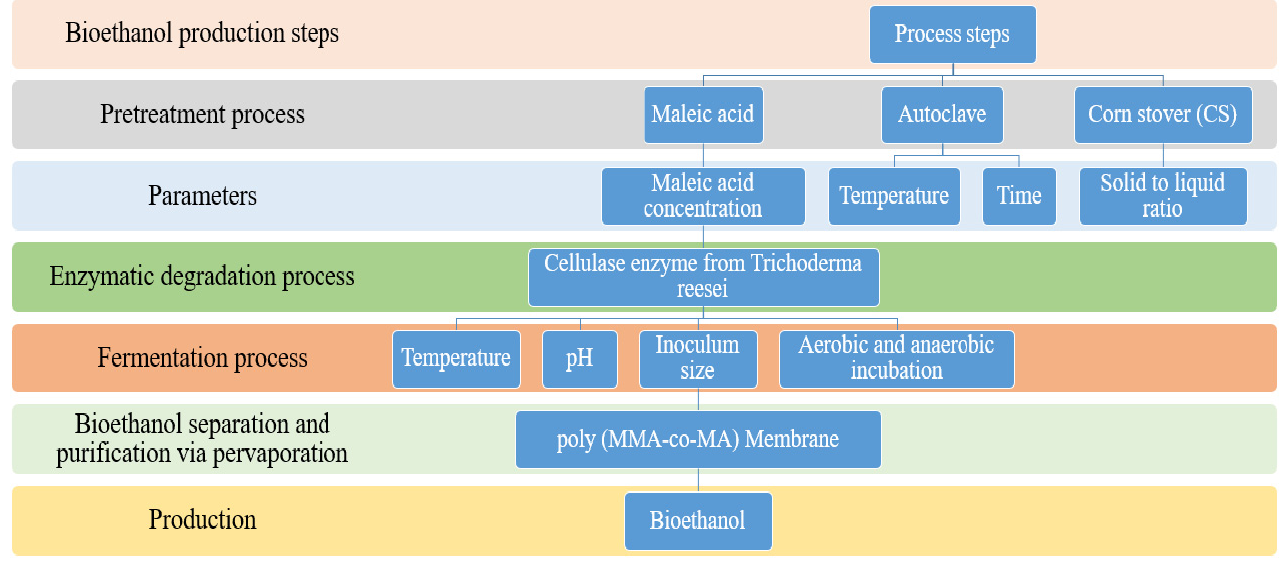
Figure 1. Schematic diagram of bioethanol production stages from CS.